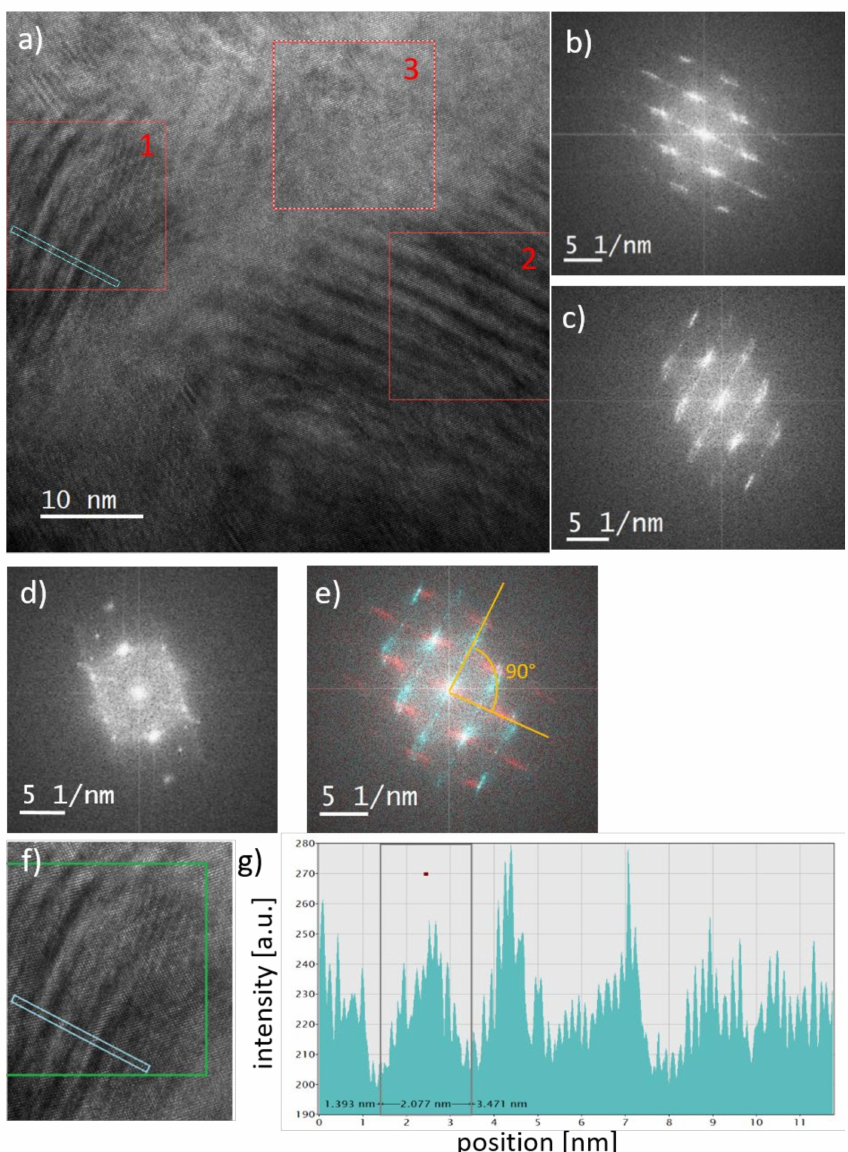
Figure 6. ( a ) HRTEM image of a section of the checkerboard. The red boxes mark the fields from that FFTs have been obtained. The FFT of box 1 is given in ( b ) of box 2 is shown in ( c ) and ( d ) corresponds to box 3. ( e ) Overlay of the FFTs b) and ( c ) illustrating the perpendicular orientation of adjacent martensite nuclei. ( f ) Enlarged image of box 1 indicating the region where a line profile across the Moir é pattern has been obtained and ( g ) the resulting line profile with a measured distance of 2.07 nm between the Moir é